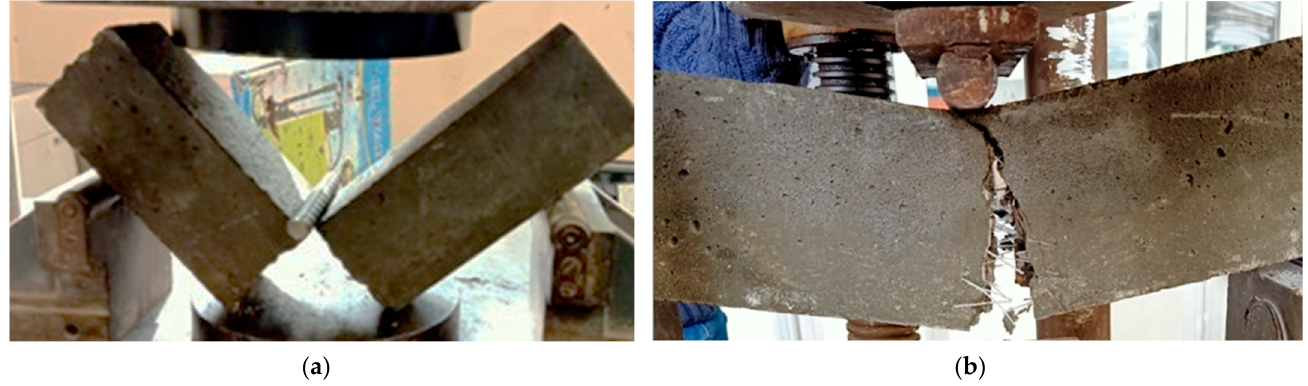
Figure 10. Cracking mechanism of concrete specimens under flexural strength test: ( a ) PCC ( b ) MSFRC.